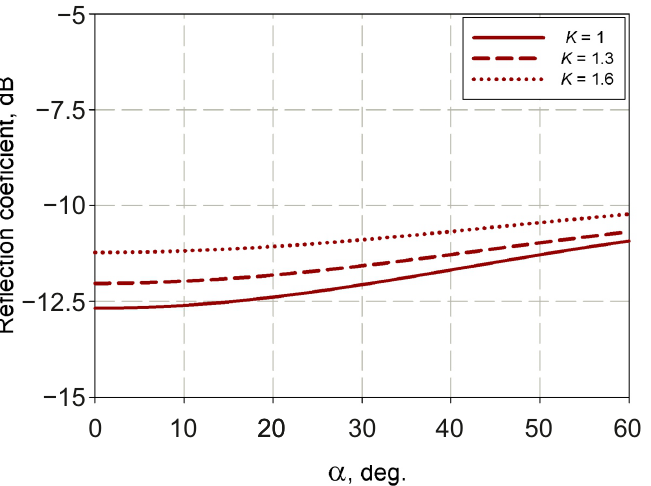
Figure 5. Reflection coefficient dependency on the incident angle at